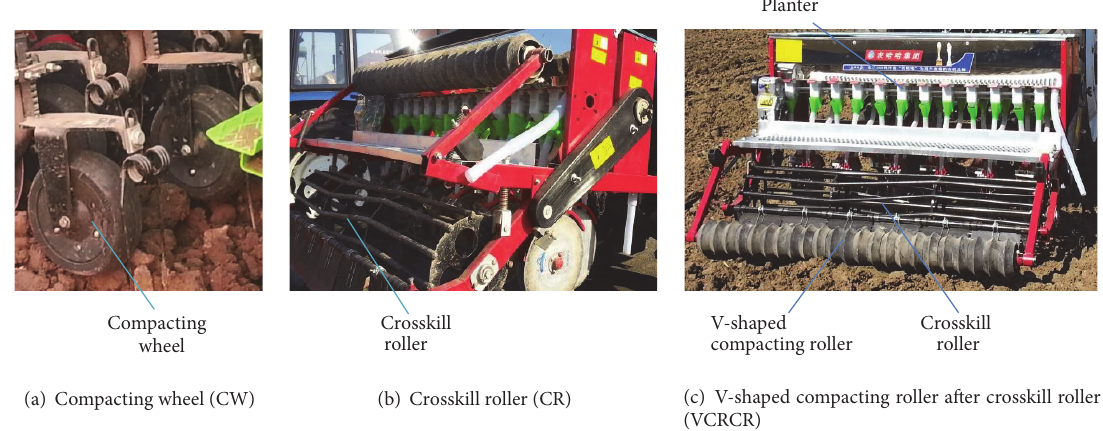
Figure 1: Postsowing compaction methods.